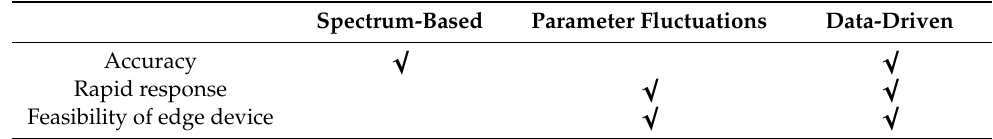
Table 1. Comparison of